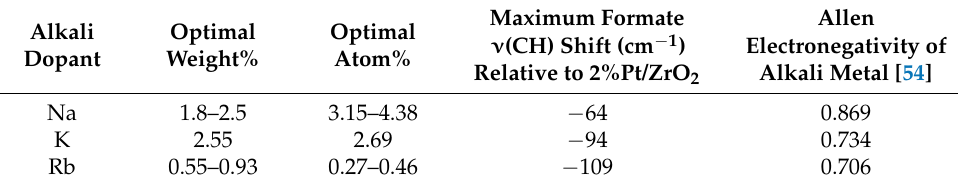
Table 5. Comparison of alkali on 2%Pt/ZrO 2